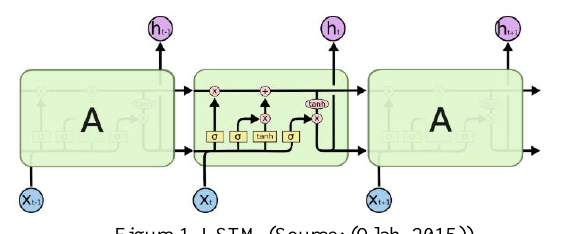
Figure 1. LSTM (Source: (Olah, 2015))